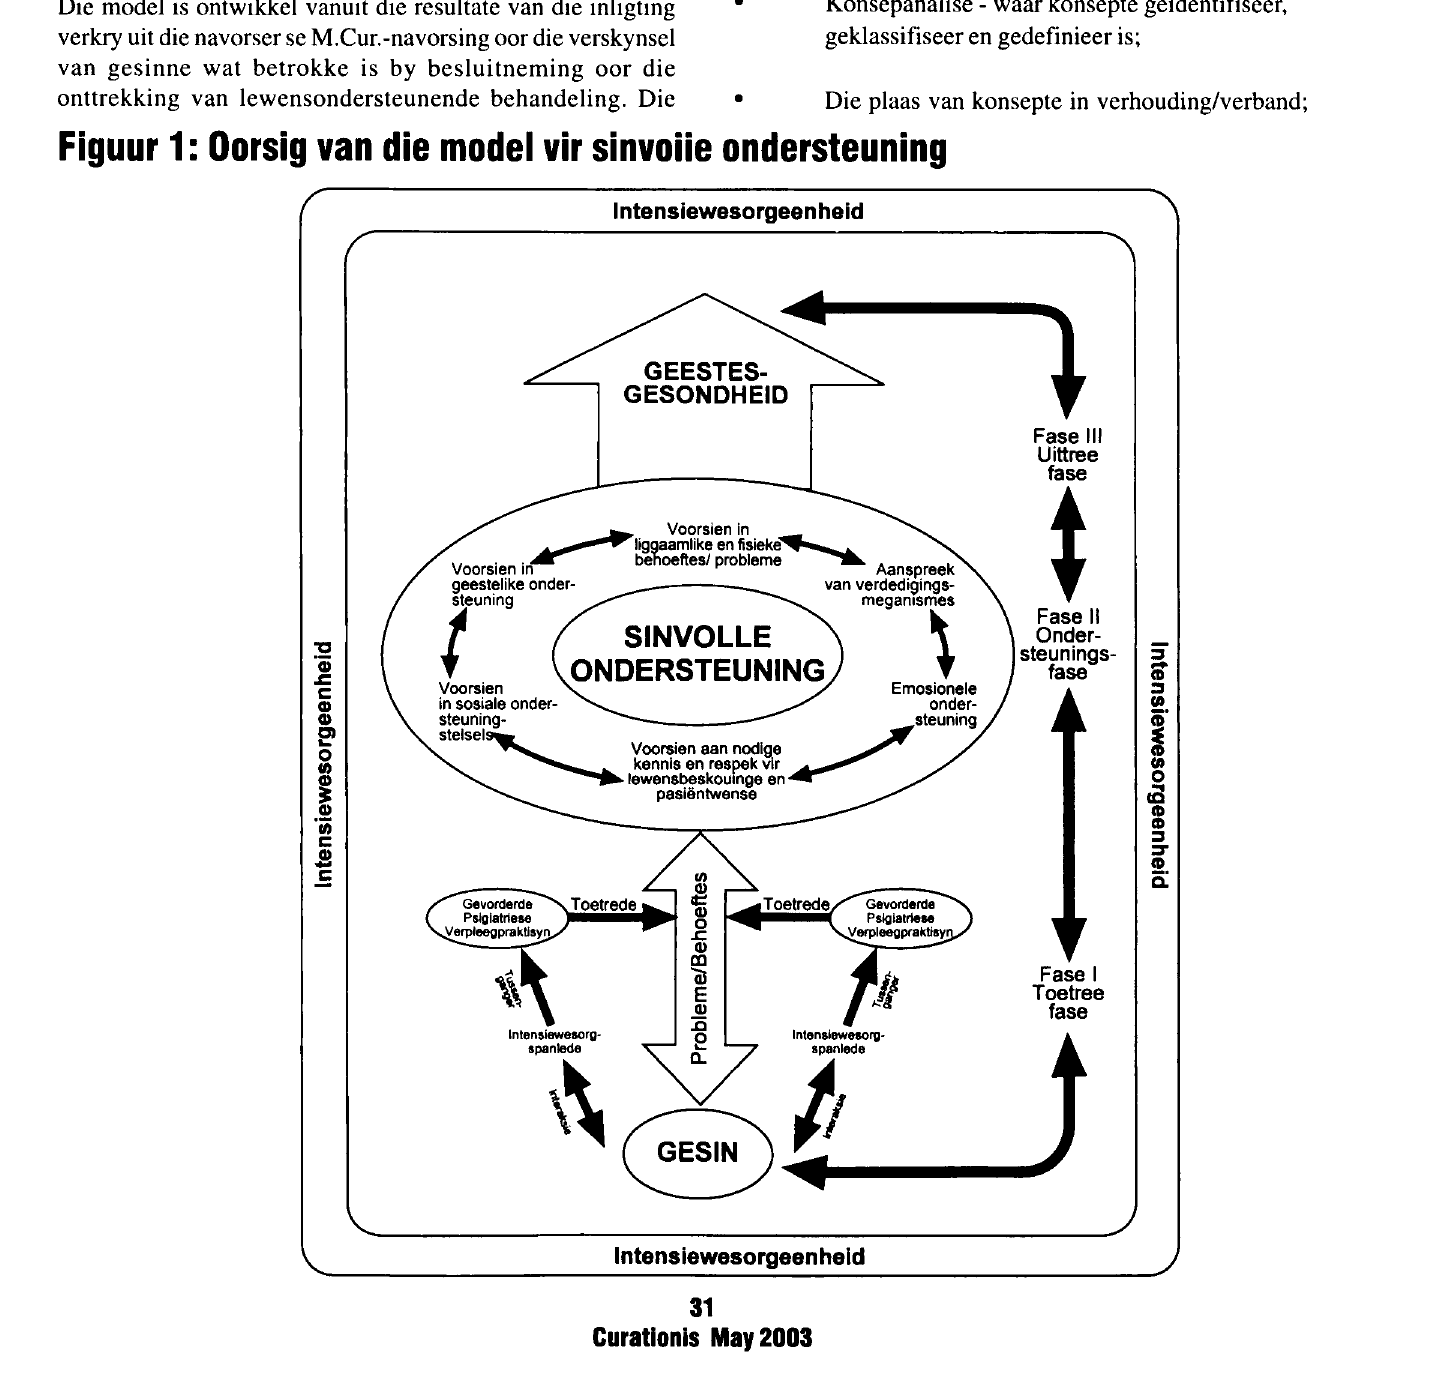
Figuur 1: Oorsig van die model vir sinvoiie